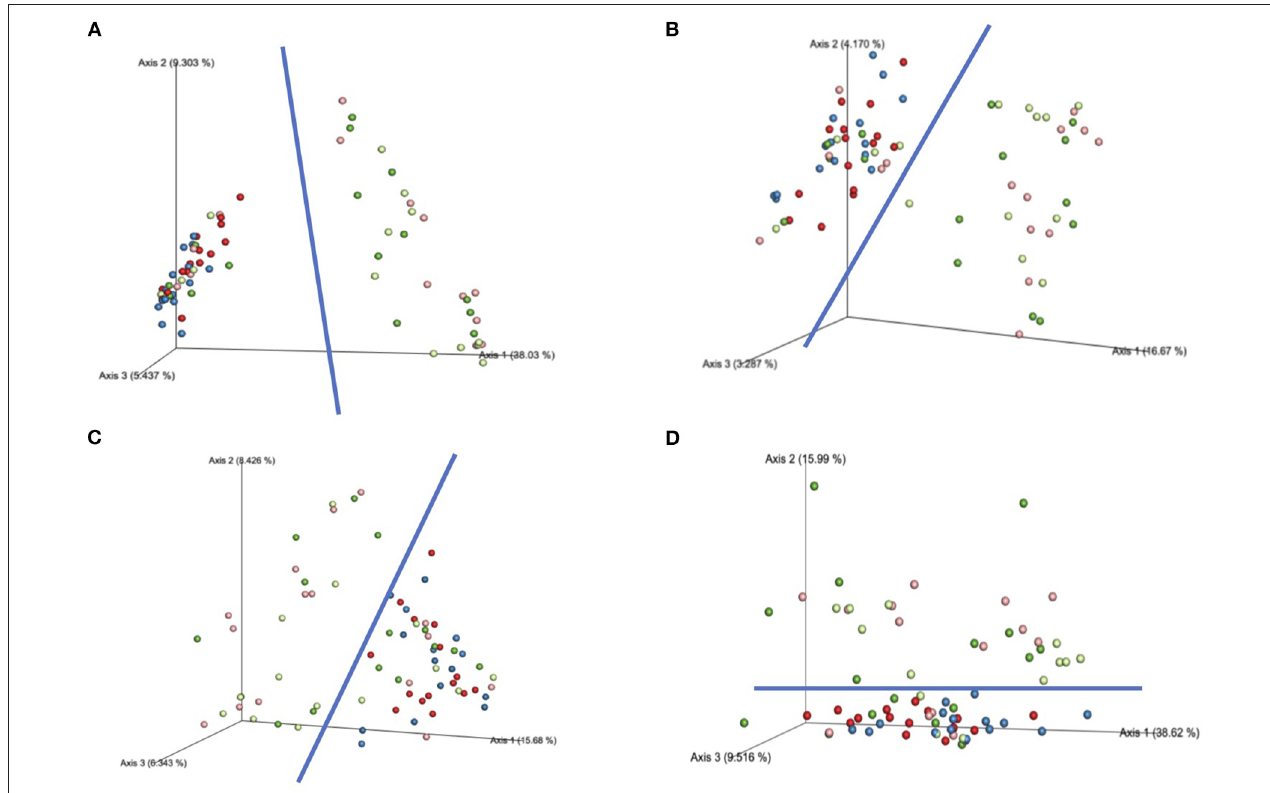
FIGURE 4 | Significant beta diversity indices by time and treatment throughout the course of sanitation. (A) Bray-Curtis Matrix, (B) Jaccard Matrix, (C) Unweighted Unifrac Distance Matrix, (D) Weighted Unifrac Distance Matrix. The colors: Red: 200 PAA, Blue: NTC, Light Green 1% SBS, Dark Green 2% SBS, Pink, 3% SBS, Blue overreaching circle represents a majority of the SBS treatments. Dark blue line represents the separation between the SBS treatments and the controls